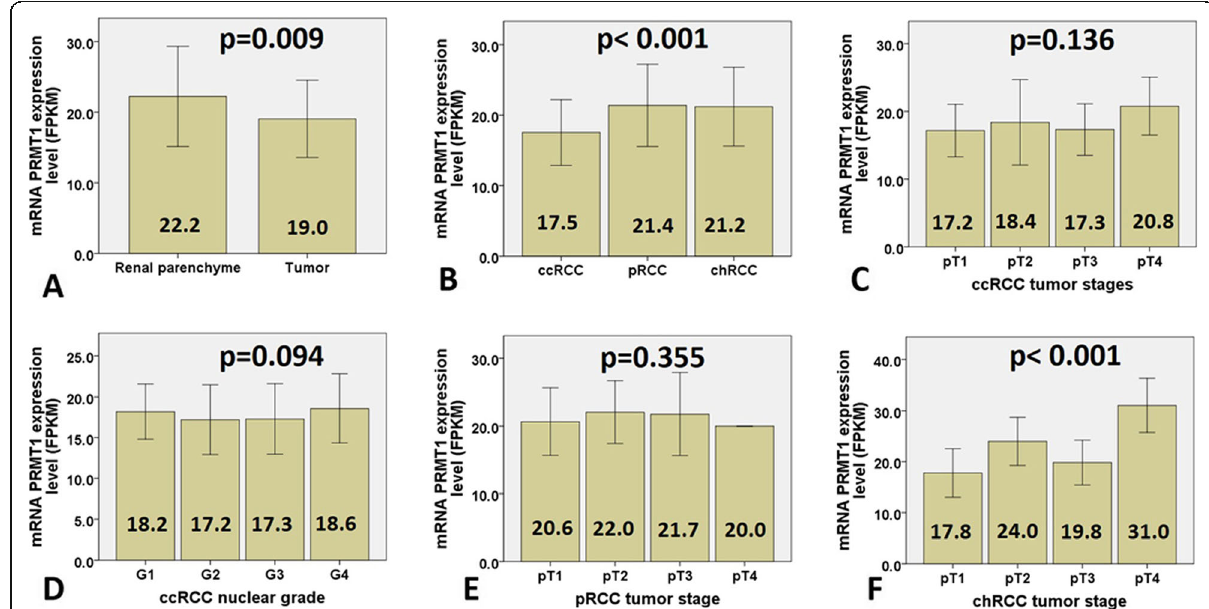
Fig. 5 mRNA PRMT1 transcript profiling data (FPKM values) for TCGA cohorts relative to tumor tissue and tumor stage. a mRNA PRMT1 expression level was decreased in tumor tissue related to non-tumor parenchyma; ( b ) In tumor tissue, mRNA PRMT1 expression level was